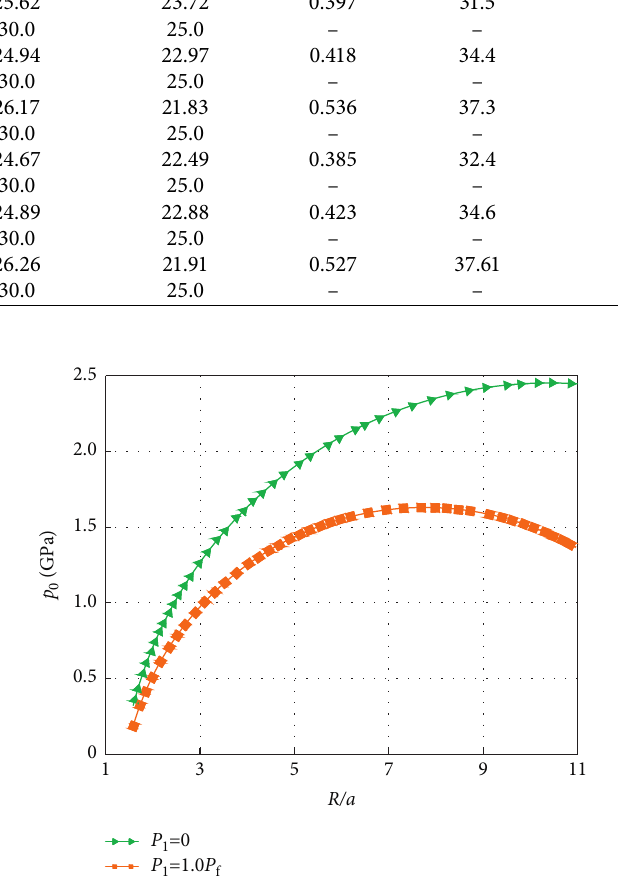
Figure 3: Correlation between groundwater pressure p